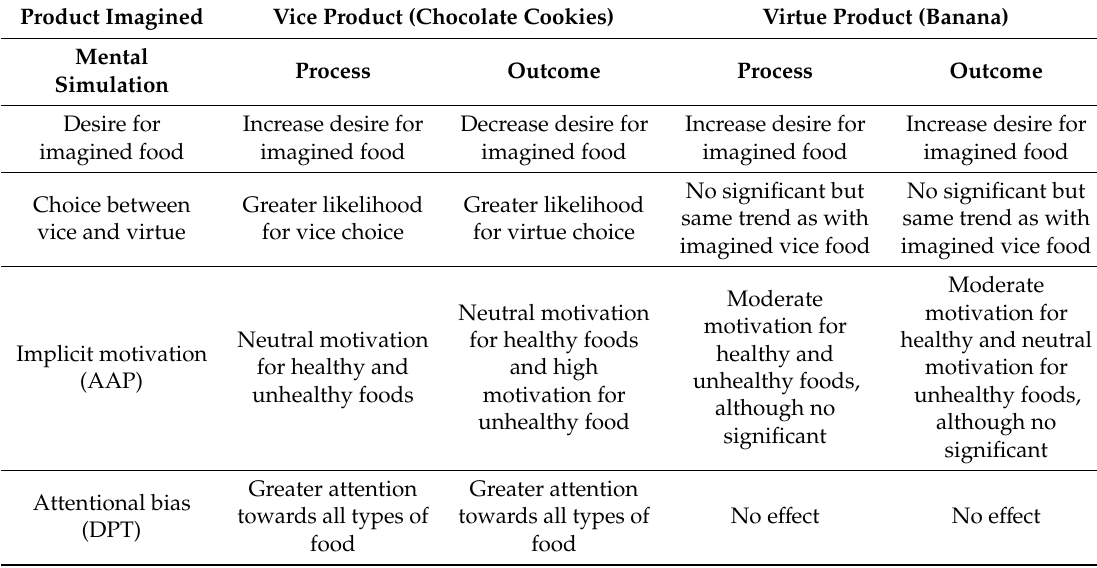
Table 3. Summary of